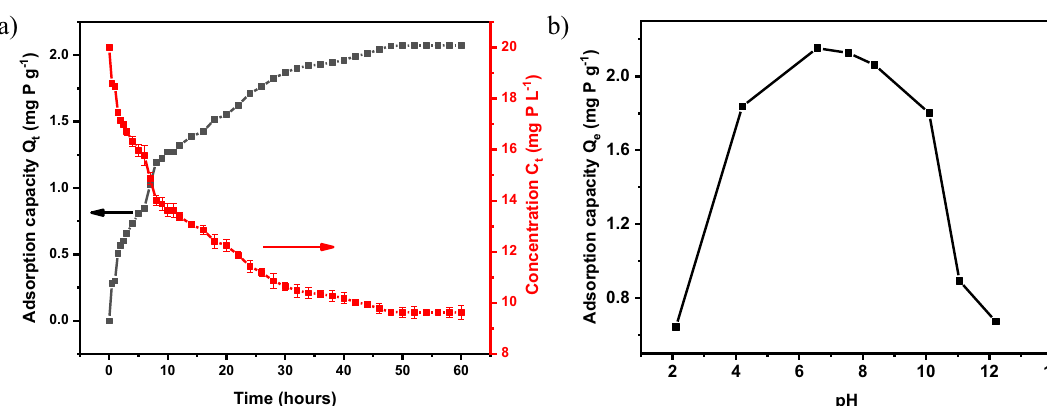
Fig. 2 Effect of time and pH on the adsorption of phosphate. a Effect of time on the adsorption of phosphate with condition: 5 g (HIAO/ 225H)/L, 20 mg P L − 1 , pH 6.0, room temperature of ∼ 30 °C). b Effect of pH on the adsorption of phosphate with condition: 50 h, 5 g (HIAO/ 225H)/L, 20 mg P L − 1 , and room temperature of ∼ 30 °C; and experimental condition ( n = 3 ±standard deviation